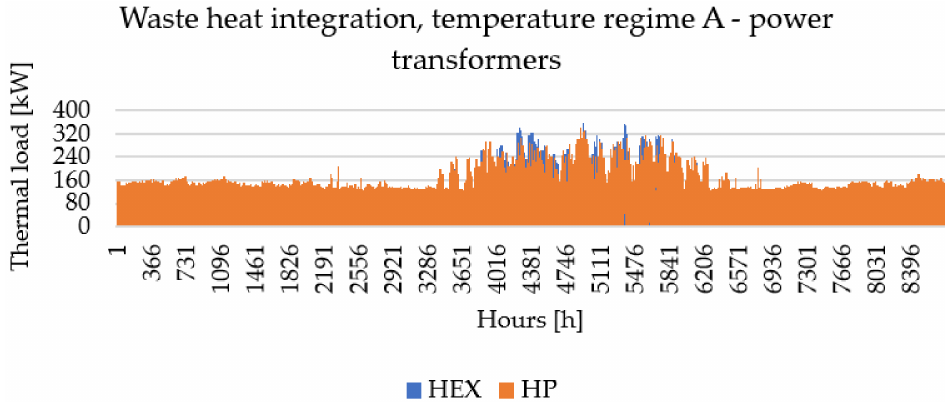
Figure A6. Waste heat utilization per technology, DH temperature regime A—power transformers.